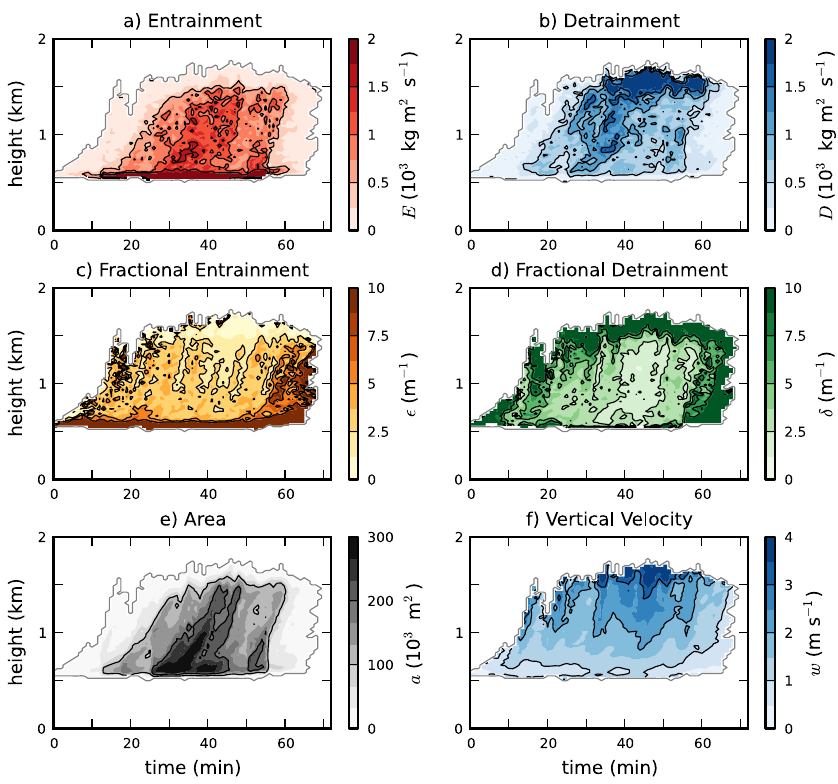
Fig. 1. Height–time profiles of cloud core (a) mass entrainment, (b) mass detrainment, (c) fractional mass entrainment, (d) fractional mass detrainment, (e) cross-sectional area and (f) vertical velocity of the longest-lived tracked cloud in the BOMEX LES output.